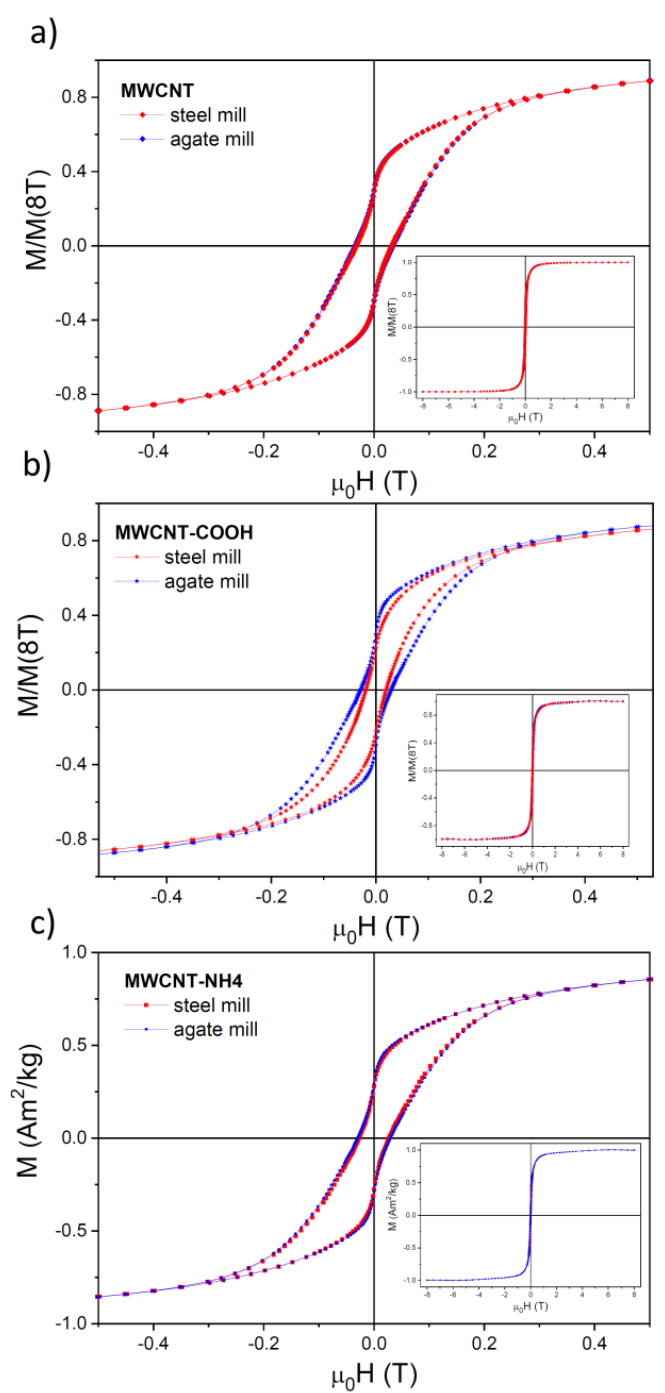
Figure 6. Field dependencies of the normalized magnetization M/M (8T) for ( a ) as prepared MWCNTs, ( b ) MWCNTs-COOH, and ( c ) MWCNTs-COONH 4 obtained from MWCNTs prepared in the agate (blue symbols) and steel (red symbols) mill at 295 K after subtracting the corresponding paramagnetic contribution. The insets show the full